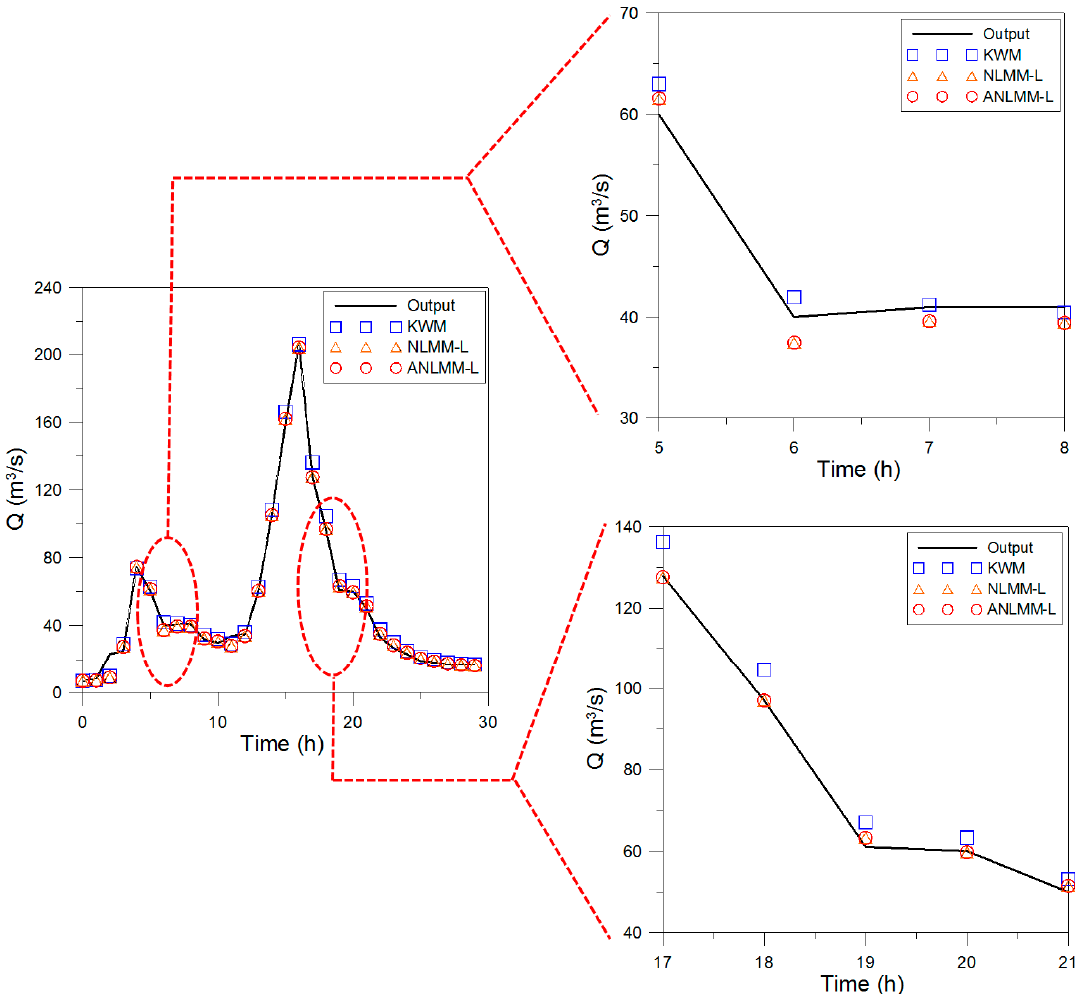
Figure 5. Comparison of results for Sutculer flood data.